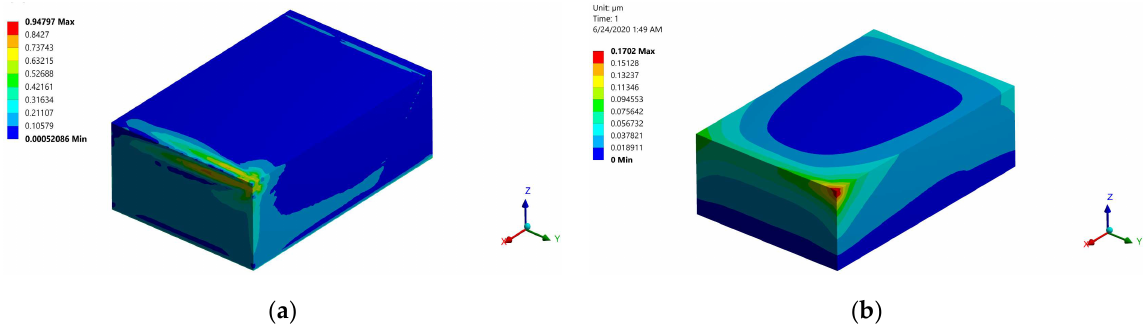
Figure 16. Normalized von Mises stress and distortion obtained using a preheating temperature of 800 K: ( a ) normalized von Mises stress; ( b ) distortion.